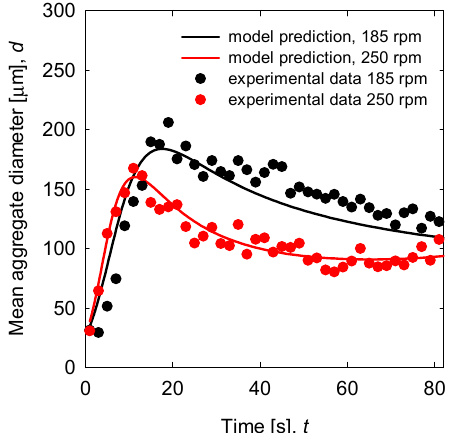
Figure 5. Experimental (symbols) vs. calculated (continuous lines) time evolution of the mean diameter of aggregates of tailing particles as a function of pH in seawater. Constant pH condition at 8.